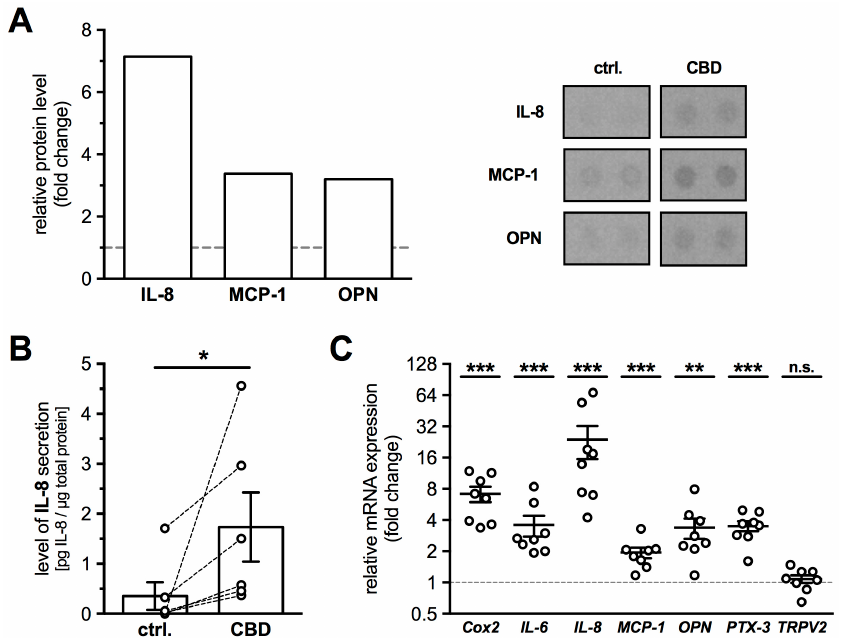
Figure 5. Activation of TRPV2 induced secretion of cytokines, especially of IL-8. ( A ) HTPCs preincubated with AM251 (80 nM) and AM630 (800 nM), and treated for 48 h with 10 µM CBD, exhibited increased secretion of IL-8 (7.1-fold), MCP-1 (3.4-fold) and OPN (3.2-fold) compared to untreated cells ( n = 1), demonstrated by a Human Proteome Profiler. Right panel shows corresponding membrane spots of untreated control and CBD (10 µM) treated HTPCs revealing an increase of signal intensity of IL-8, MCP-1 and OPN. ( B ) Using an immunoassay, significantly increased IL-8 levels could be detected in culture media of HTPCs from six individual patients treated for 24 h with 10 µM CBD in the presence of CB1 and CB2 blockers (1.74 ± 0.69 pg/µg total protein), compared to the corresponding control condition (0.35 ± 0.28 pg/µg total protein). Results were normalized to total protein amount and statistically analyzed using Wilcoxon test (two-tailed, paired test: p = 0.0312; n = 6). ( C ) Quantitative PCR revealed significantly increased mRNA expression levels of Cox2 , IL-6 , IL-8 , MCP-1 , OPN and PTX-3 in HTPCs after 24 h stimulation with 10 µM CBD and CB1 and 2 blockers. mRNA levels of TRPV2 did not show any significant changes (1.08 ± 0.09-fold; p = 0.5905). n = 8; * p ≤ 0.05, ** p ≤ 0.01, *** p ≤ 0.001 vs. control cells.